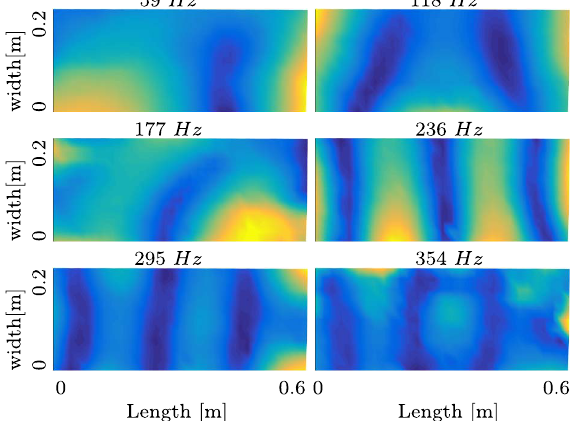
Figure 10. Operational de fl ection shapes for the pulsation frequencies of the segment with curved tube on the surface (Fig. 6.II).